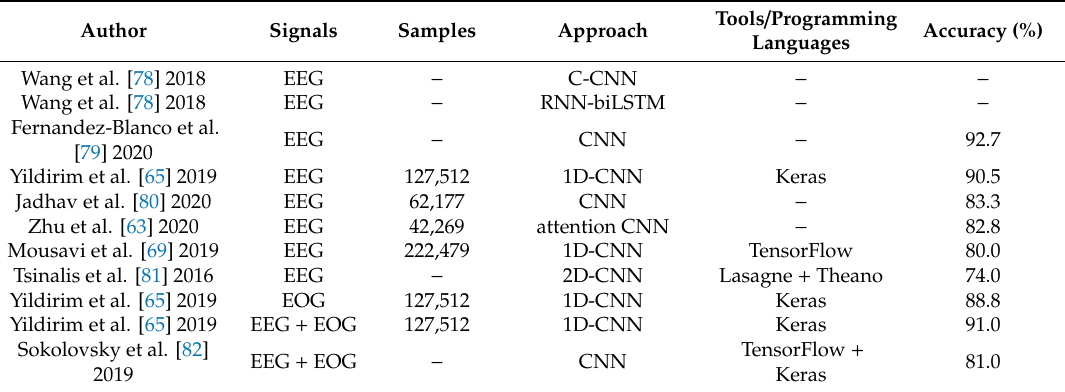
Table 2. Summary of automated sleep stage classification approaches with DL applied to PSG recordings in Expanded Sleep-EDF dataset.